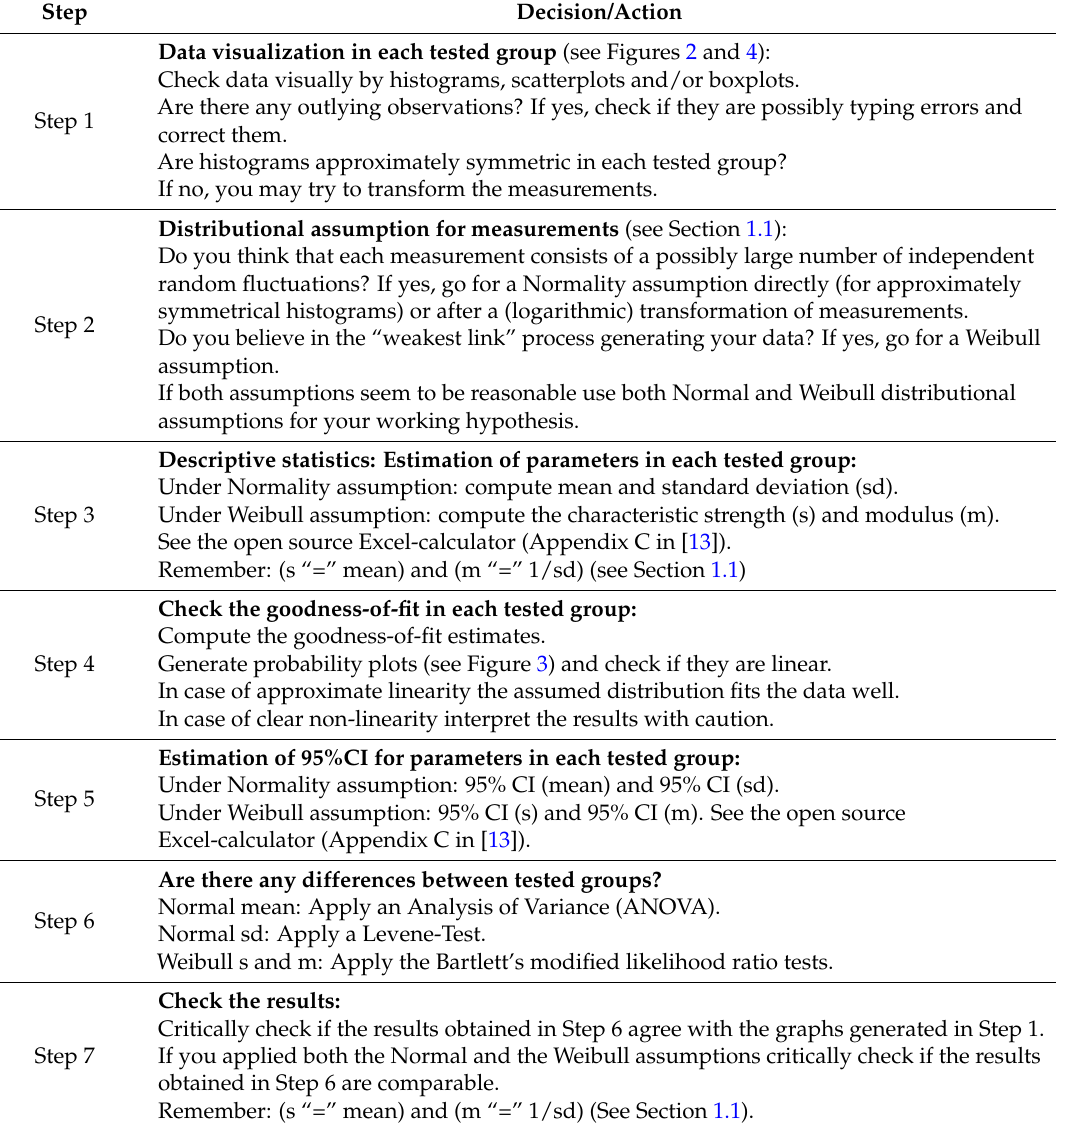
Table 5. A recommended statistical analysis workflow for flexural strength measurements. If not otherwise indicated [29] can be used (path: Stat/Reliability-Survival/Distribution Analysis (Right Censoring)/Parametric Distribution